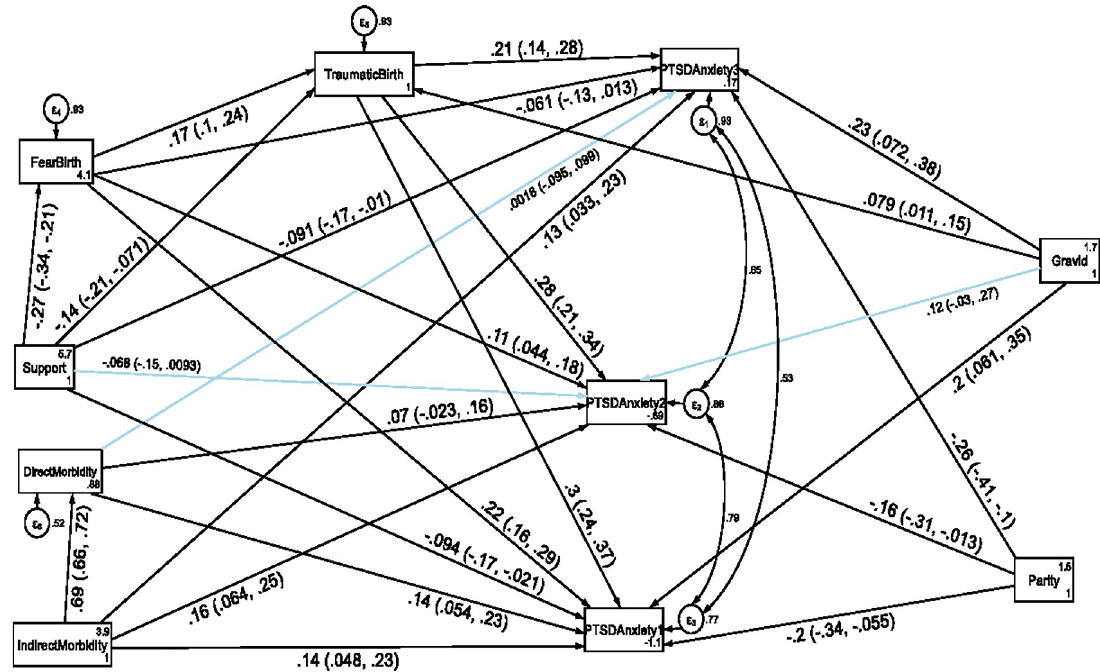
Fig 7. A structural equation model of the factors associated with comorbidity of anxiety and PTSD symptoms in postpartum women, Northwest Ethiopia. Note: β ’s are standardized estimates with 95% CI.